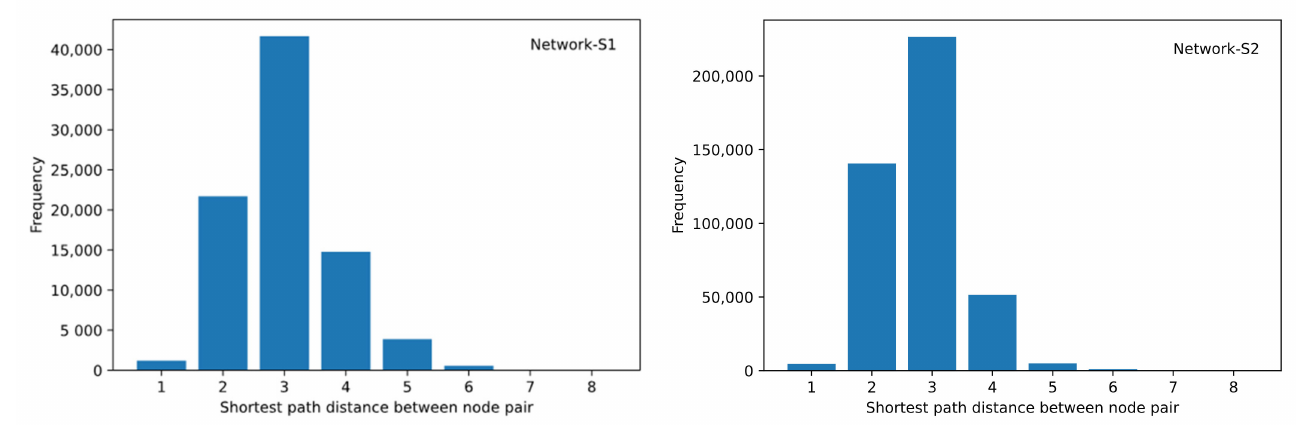
Figure 4. Complementary cumulative degree distribution of the two networks.